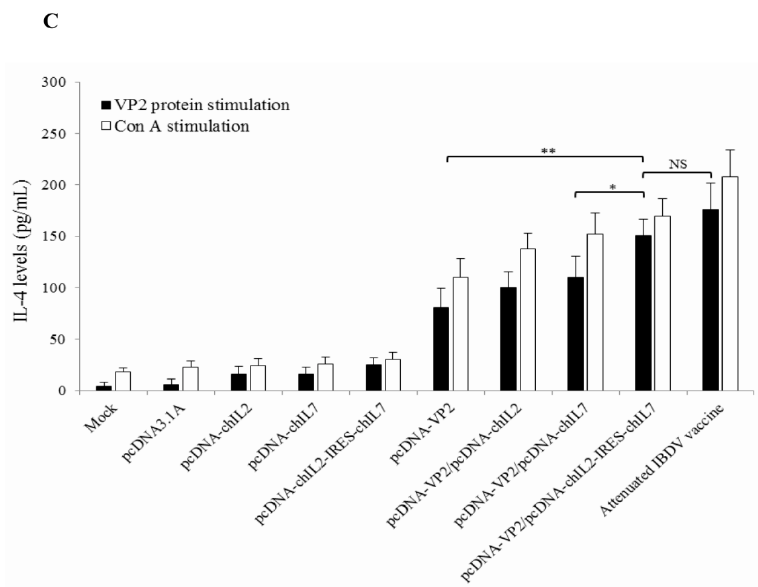
Figure 5. Lymphocyte proliferation and cytokine production in immunized chickens. ( A ) Lymphocytes were isolated from individual immunized chickens at 35 d post-immunization and re-stimulated with VP2 protein for 72 h or with Con A for 2 h in vitro. The stimulation indexes for each group immunized with di ff erent vectors were measured by MTT assay. ( B ) and ( C ) IFN- γ and IL-4 concentrations in culture media of lymphocytes from di ff erent immunized chickens were measured by ELISA. Values are expressed as mean ± SD. ** p < 0.01, * p < 0.05, NS, no significance.